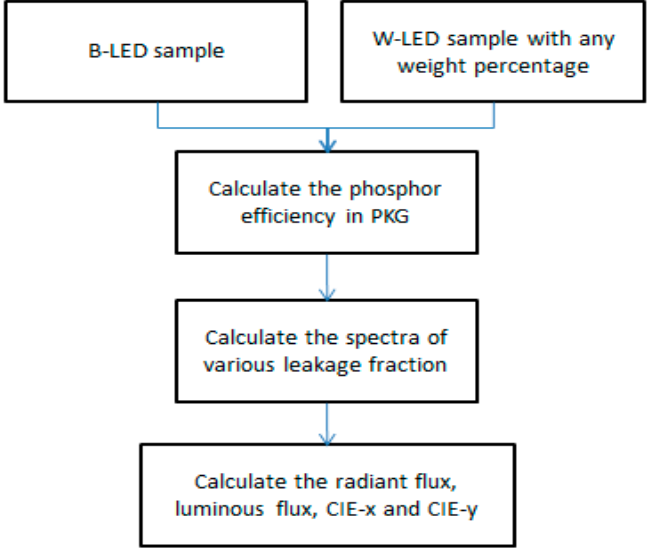
Figure 2. Flowchart of the singular phosphor model.